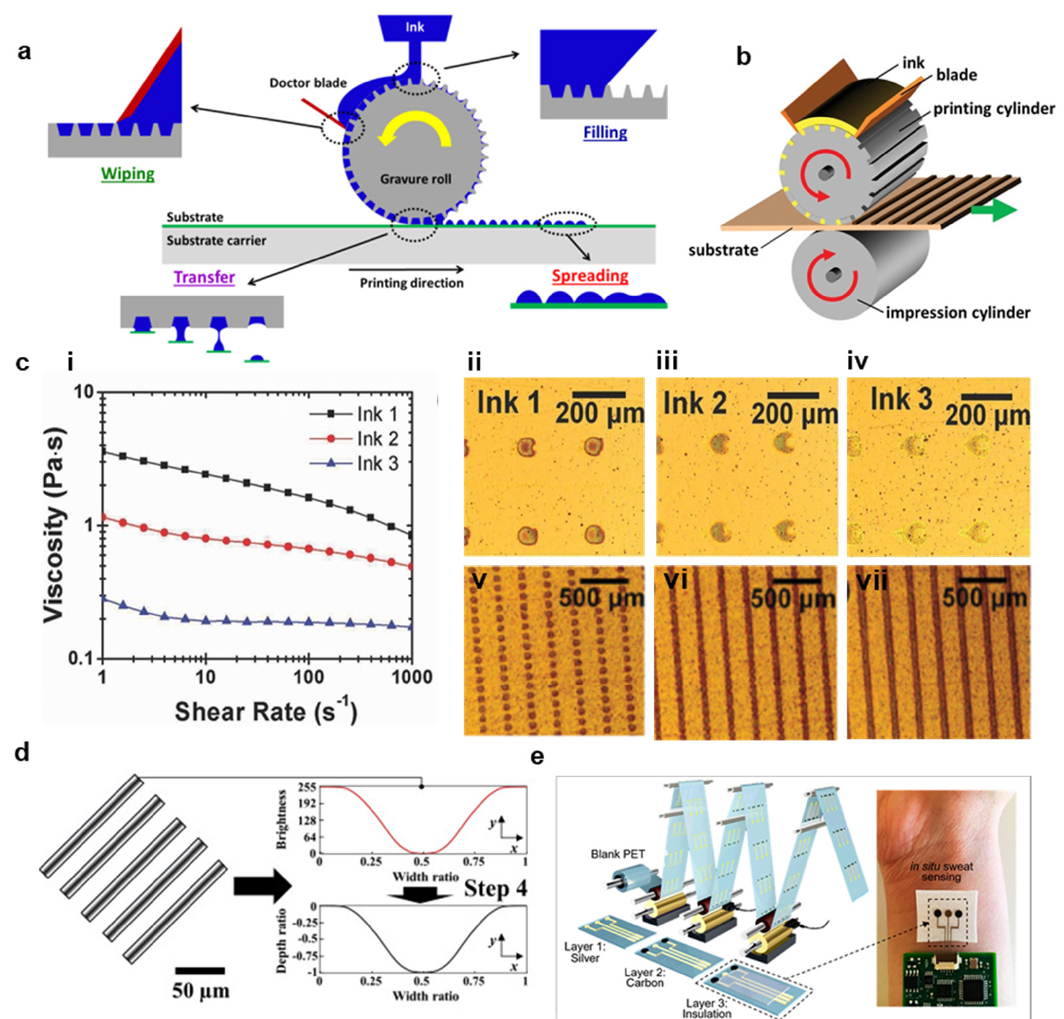
Figure 2. Gravure printing of hybrid bioelectronics. ( a ) Overview of the gravure printing process (reprinted with permission from Flex. Print. Electron (2016), 1 023003. Copyright 2016, IOP). ( b ) Illustration of gravure printing linear traces against an impression roll. (reprinted with permission from Adv. Mater. (2019), 31, 1806702. Copyright 2020, Wiley). ( c ) Optimizing graphene inks for gravure printing. ( i ) Characterization of viscosity for the three different ink formulations. ( ii – iv ) Images of printed dots for each ink using a gravure cell of 50 µ m. ( v – vii ) Images showing line formation as the cell spacing is reduced, corresponding to 50, 25, and 5 µ m spacing for a cell size of 50 µ m. (reproduced with permission from Adv. Mater. (2014), 26: 4533–4538. Copyright 2014, Wiley). ( d ) Optimized cell patterns achieved with gradation engraving to achieve high-resolution gravure printing. (reprinted with permission from Precis. Eng. (2021), 69: 1–7. Copyright 2021, Elsevier). ( e ) Illustration of roll-to-roll printed sweat sensors. (reprinted with permission from ACS Nano (2018), 12(7): 6978–6987, Copyright 2018, ACS).